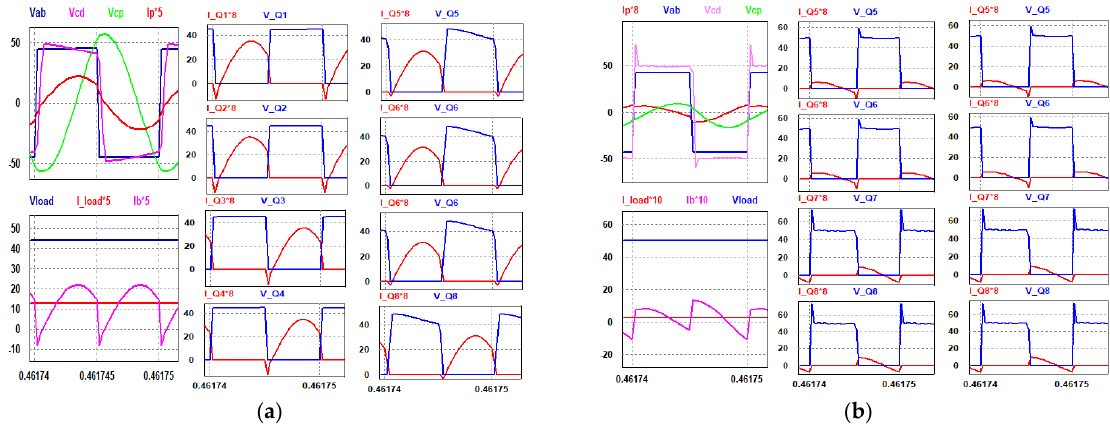
Figure 10. ( a ). Simulation results in FM mode with 100% Load at V in(max) = 18 V, v ab , v cd , i p and v cr . Soft-switching characteristics for the primary ( Q 1 to Q 4 ) and secondary side ( Q 5 to Q 8 ) switches are also shown. ( b ). Simulation results in forward mode (FM) with 10% Load at V in(max) = 18 V, v ab , v cd , i p and v cr . Soft-switching characteristics for the primary ( Q 1 to Q 4 ) and secondary side ( Q 5 to Q 8 ) switches are also shown.